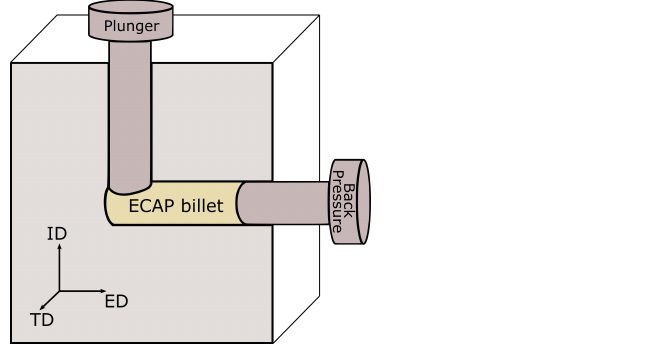
Figure 1. Scheme of the ECAP die with the coordinate system. The abbreviations ID, ED and TD represent the insert, extrusion and transverse directions, respectively.